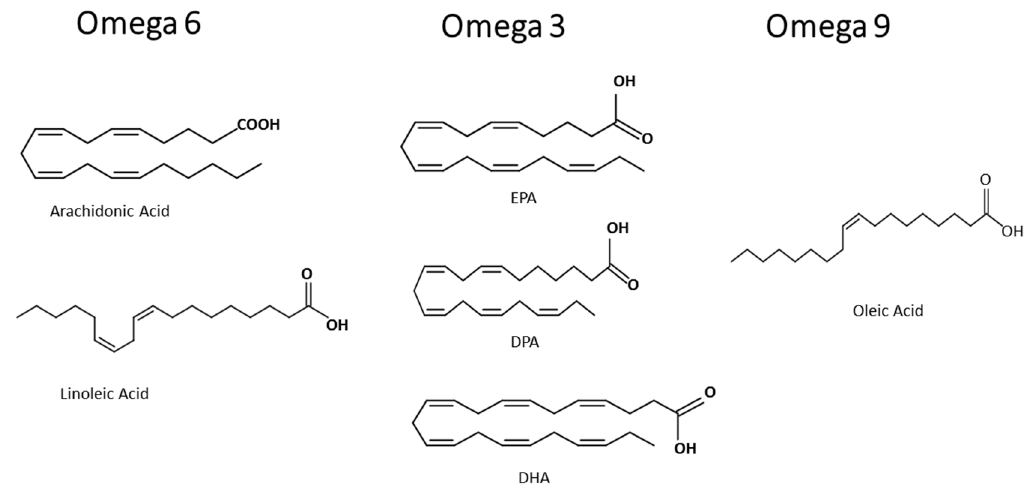
Figure 1. Structures of typical omega ‐ 6, omega ‐ 3, and omega ‐ 9 fatty acids.